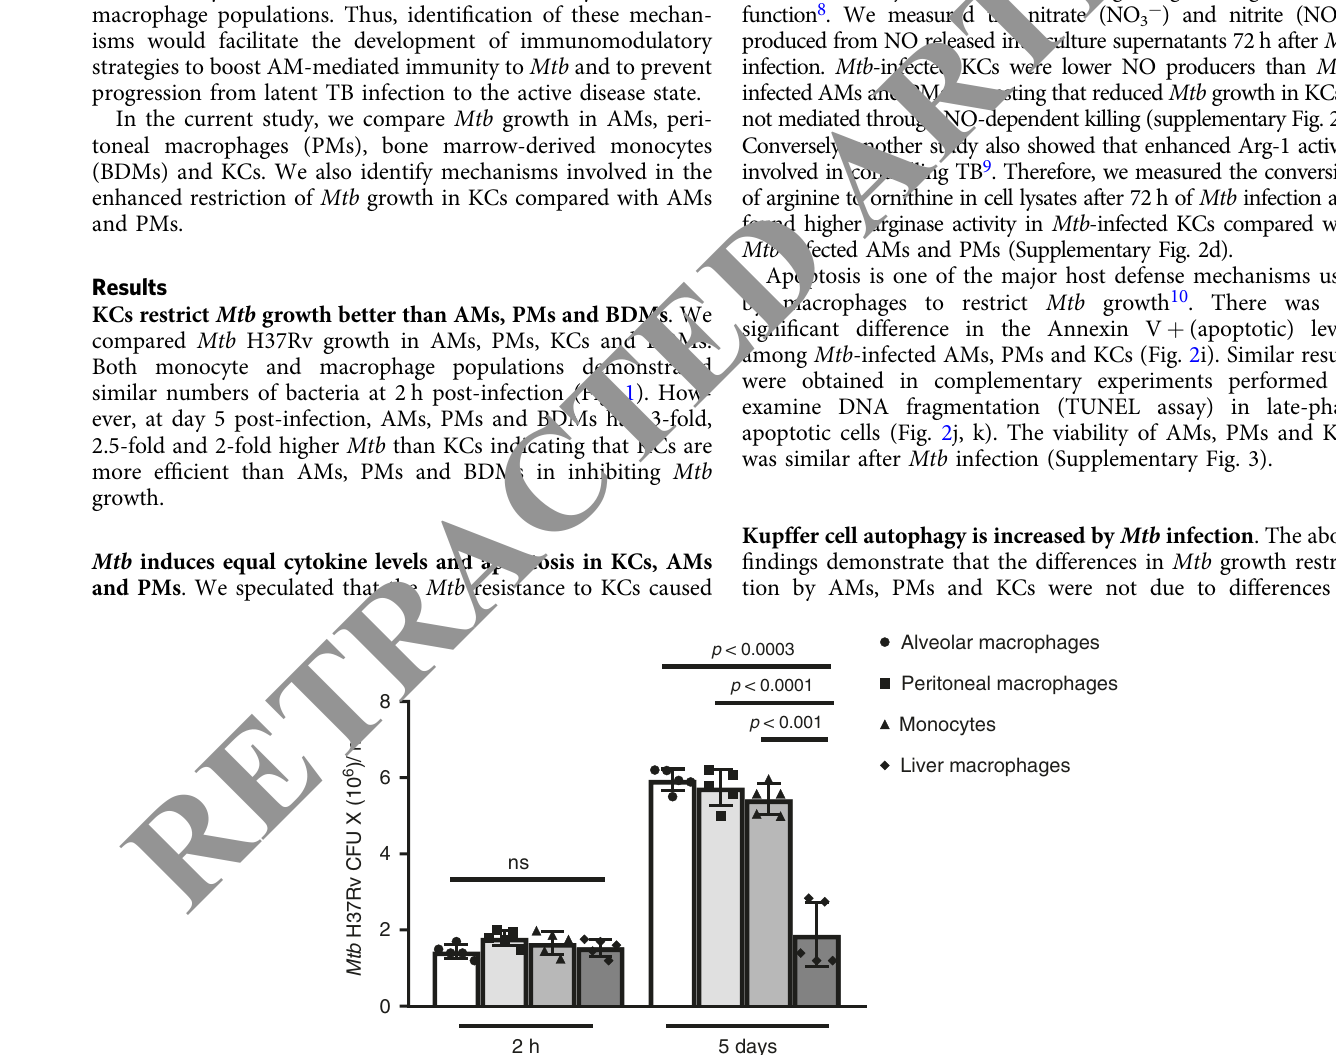
Fig. 1 KCs restrict Mtb growth better than AMs, PMs and BDMs. Alveolar (AMs), peritoneal (PMs) and liver macrophages (KCs) as well as bone marrow-derived monocytes (BDMs) from C57BL/6 mice were isolated and infected with Mtb H37Rv at an MOI of 1:2.5 (1 AM, PM, KC, BDMs and 2.5 Mtb ). Intracellular CFUs were demonstrated 2 h and 5 days post-infection. Statistical analysis was performed with paired two-tailed t test and mean ± SDs are shown. p < 0.0003, p < 0.0001, p < 0.0015, ns: not signi fi cant. The data shown are the average of fi ve independent